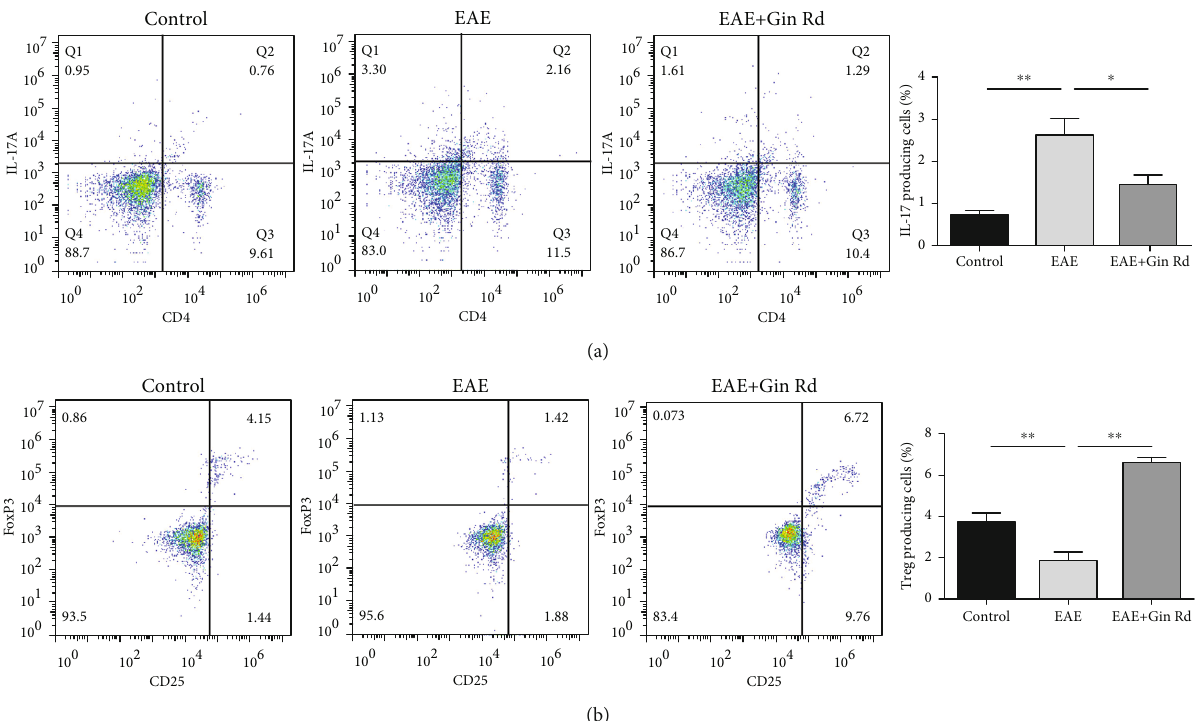
Figure 4: Ginsenoside Rd treatment modulates Treg/Th17 cell imbalance in EAE mice. Following immunization and treatment with Ginsenoside Rd, some mice from the control, EAE, and Ginsenoside Rd-treated EAE groups were sacri fi ced at day 20 postimmunization; splenocytes were isolated. The percentages of CD4+ IL-17+ Th17 cell (a) and CD4+ CD25+ Foxp3+ Treg cells (b) in each group were determined by fl ow cytometry ( n = 3 ). Data are expressed as the mean ± SD for each group ( n = 3 ). ∗ P < 0 : 05 , ∗∗ P < 0 : 01 vs. EAE group. Gin Rd: Ginsenoside Rd.